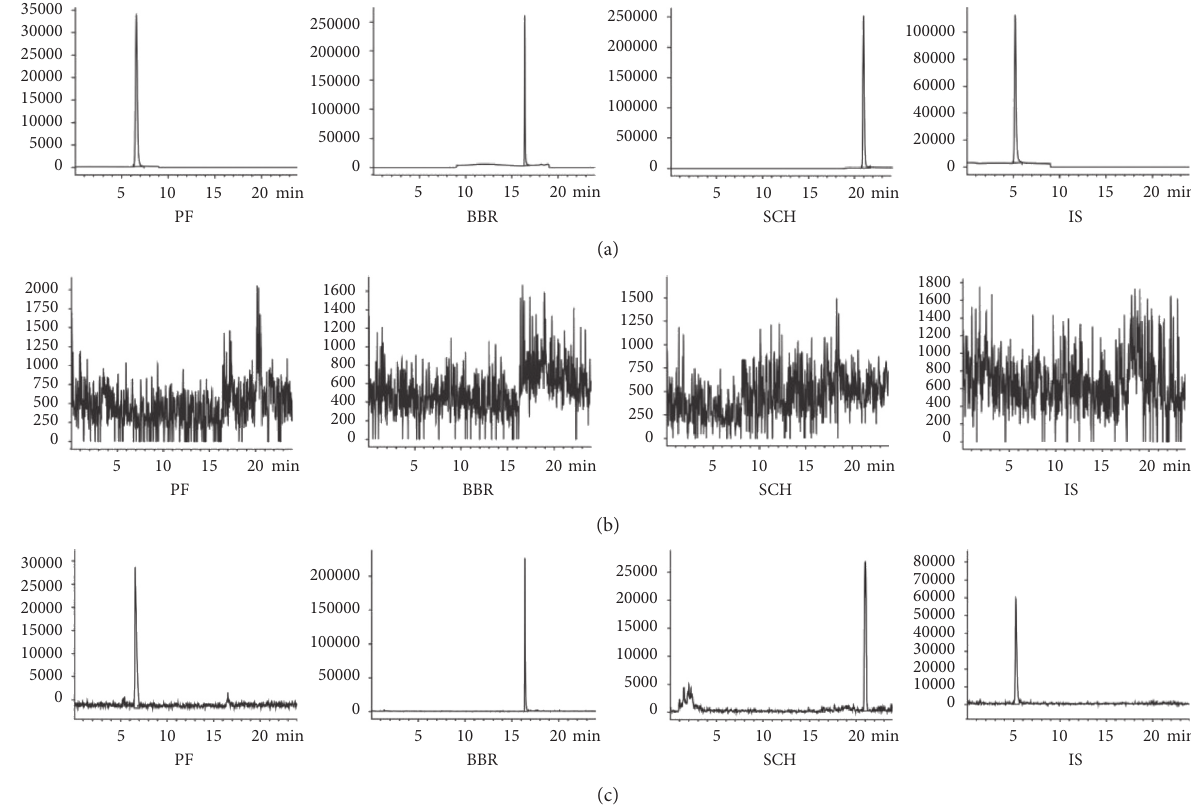
Figure 4: The chromatograms of related solutions for BSPs: (a) solution of mixed reference compounds, (b) blank sample solution, and (c) sample solution. Table 1: The calibration curve, correlation coefficient, and linear range of three ingredients in BSPs.